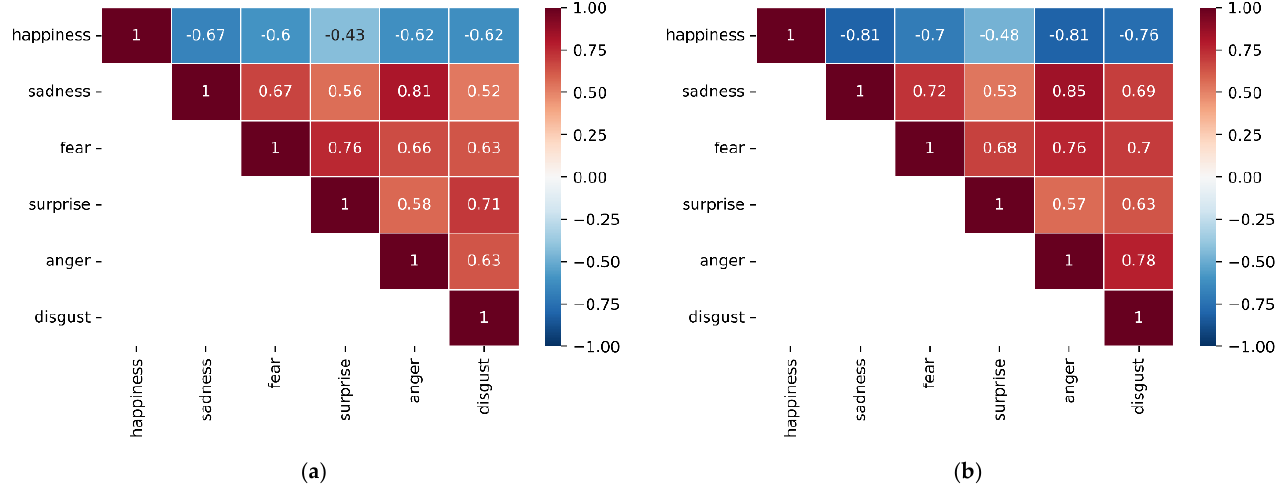
Figure 6. Correlations between 6 emotion norms (happiness, fear, sadness, surprise, anger, disgust) in the NAPS BE dataset: ( a ) Pearson correlation coefficient matrix ( r ); ( b ) Spearman ’ s rank matrix ( r s ).